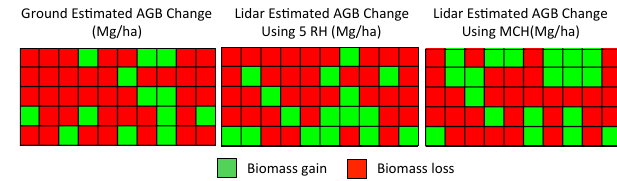
Fig. 7. AGB change (in Mgha − 1 ) from ground estimations (a) and from lidar estimations ( b and c ) in the 50ha plot at 1ha spatial scale. lidar estimates do not clearly show the same AGB change trends as the ground